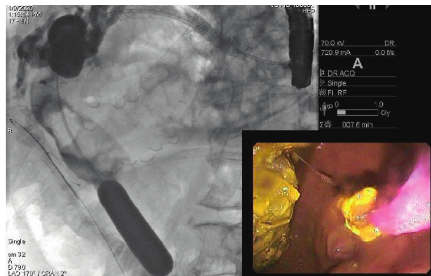
Figure 6: Antegrade balloon sphincteroplasty to facilitate stone